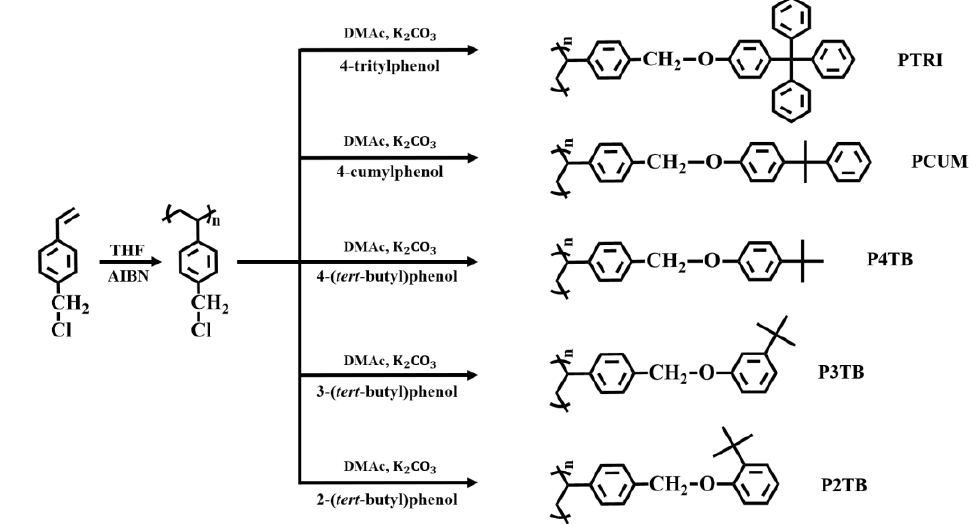
Figure 1. Synthetic routes of PTRI, PCUM, P2TB, P3TB, and P4TB films.